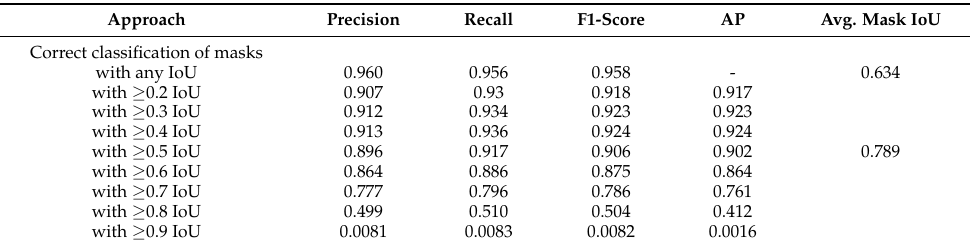
Table 1. Evaluation Results as calculated via the manually annotated dataset; AP: Average Precision, IoU: Intersection over